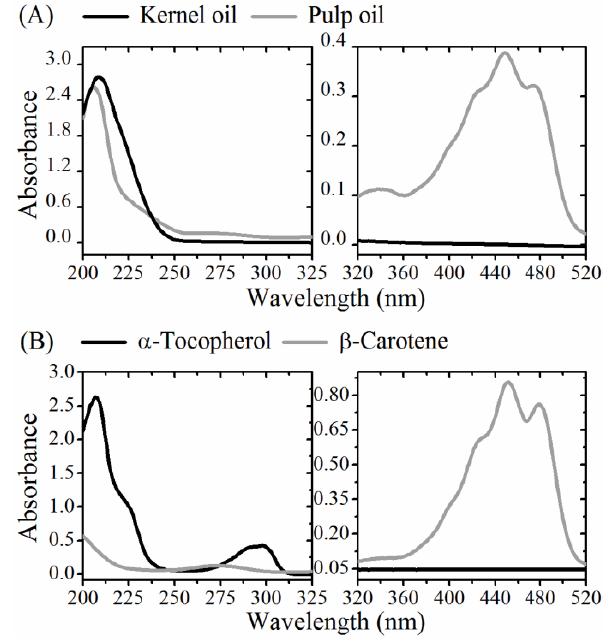
Figure 1. UV-Vis absorption spectra of the ( A ) A. aculeata kernel and pulp oils and ( B ) α-Tocopherol and β-Carotene. Samples diluted in hexane in the concentrations of 0.75 w / v (oils), 50 mg·L −1 (α-Tocopherol), and 3 mg·L −1 (β-Carotene).